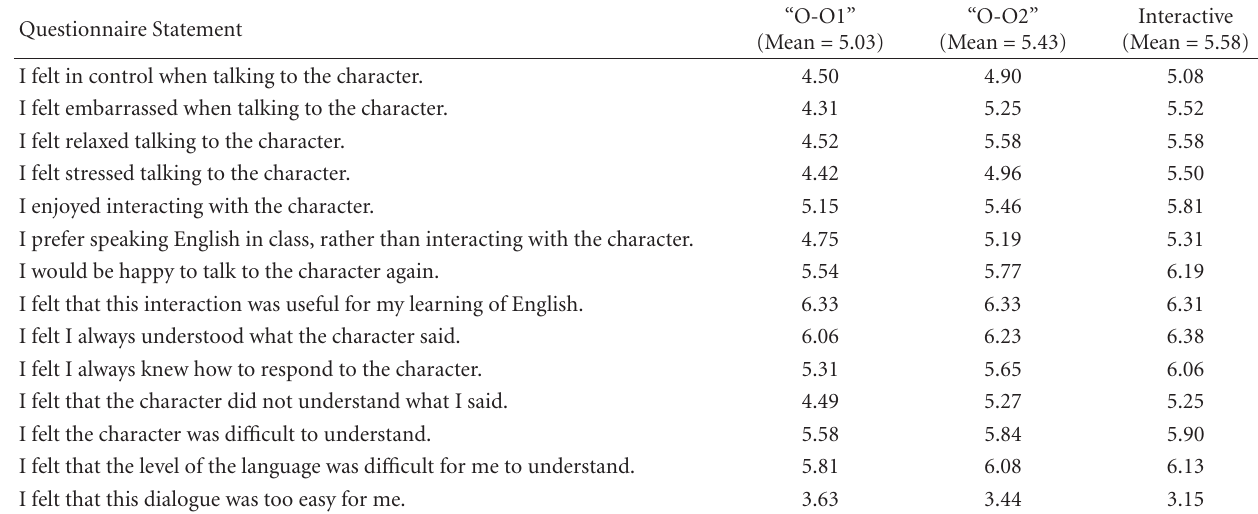
Table 1: Overall mean scores speech enabled